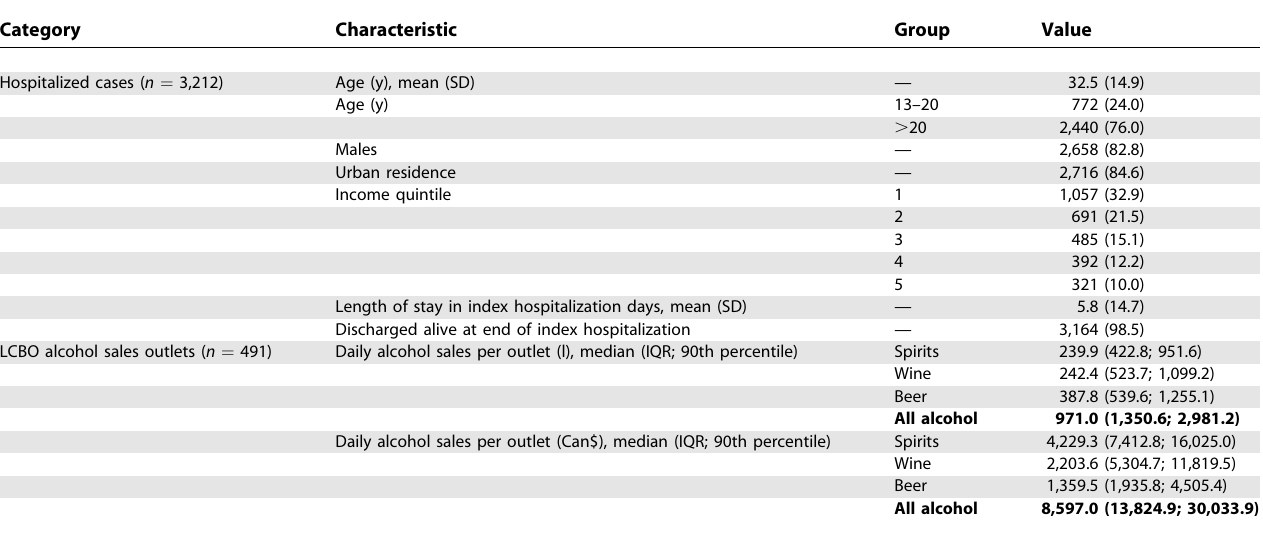
Table 1. Characteristics of Persons Hospitalized for Assault, and Descriptions of the Alcohol Sales Outlets Category